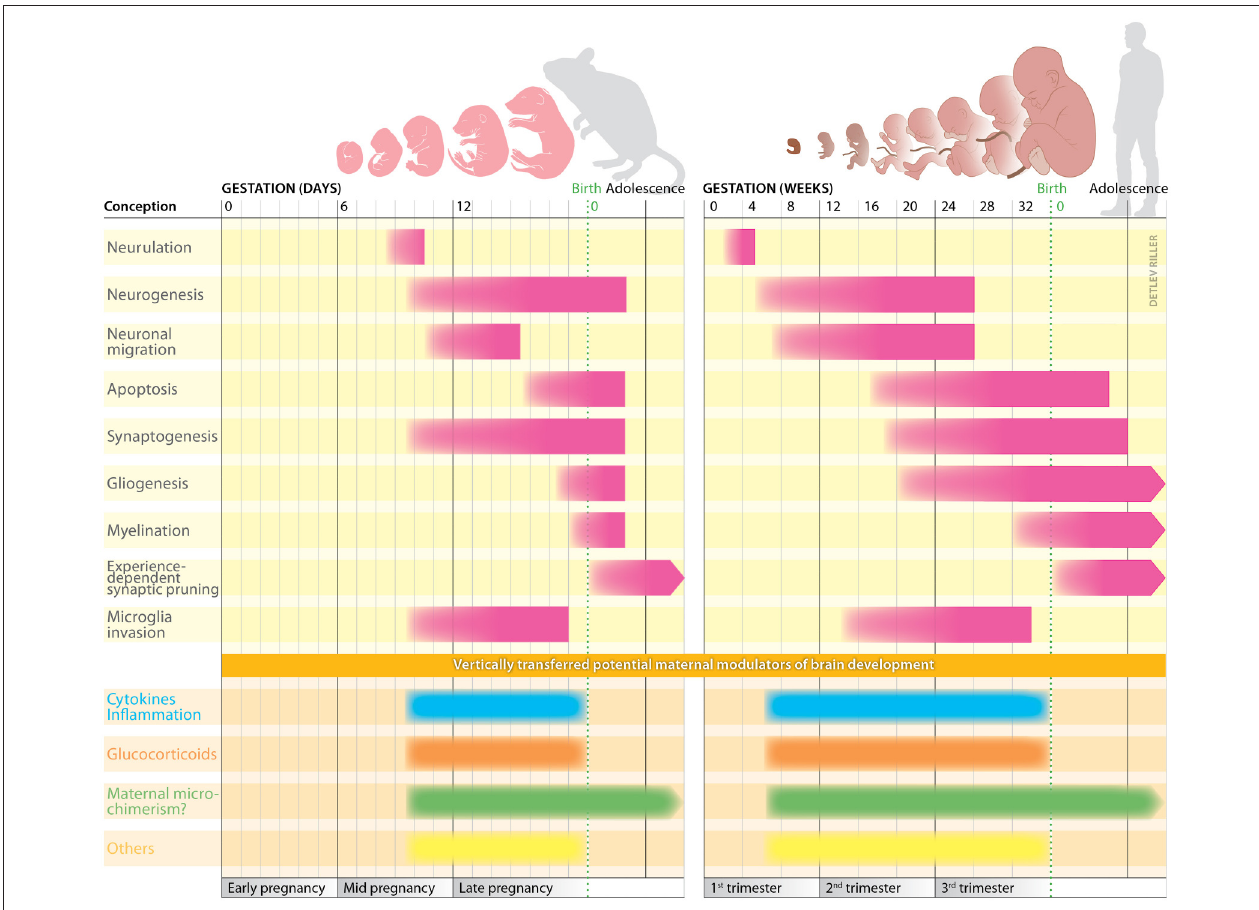
FIGURE 1 | Milestones of brain development in mice and humans. In both species, brain development commences with neurulation, a process creating the neural tube. This provides the prerequisite for the subsequent production of neuron from neural stem cells, a process defined as neurogenesis. Early during human development, at gestation week 4, the anterior part of the neural tube begins to form into distinct regions. The forebrain, midbrain and hindbrain are defined as the anterior part; the spinal cord is located at the posterior part. Two weeks later, the neural tube can be clearly divided into the brain regions that are present at birth. Some of the previously produced neurons now start to migrate to distinct brain regions, a process that continues until approx. week 26. Earlier by week 11, the cerebrum has developed—more rapidly than other structures—and largely covers the entire brain, except cerebellum and medulla oblongata. Due to its progressive development within the cranium, the cerebrum is forced to convolve itself resulting in gyri and sulci ( 51). During the second trimester of pregnancy, several processes start to define brain connectivity. These include synaptogenesis, gliogenesis, and apoptosis. Simultaneously, microglial cells invasion begins. By mid-third trimester, the fine-tuning of neuronal connectivity starts with proliferation of myelin sheaths throughout the neurons of the central nervous system (52). Shortly after birth, the previously established neuronal connections are reduced based on neuronal activity, meaning a reduction of neuronal connections to the ones often used. Since murine gestation is much shorter compared to human pregnancy, some developmental steps continue to proceed after birth. In mice, neural development begins during mid-pregnancy, followed by neurulation and formation of the neural tube (53). Subsequently, production of neurons, their migration and the formation of synapses occur almost simultaneously. Also, yolk sac-derived microglial cells invade the fetus starting on day 9 of pregnancy (54). The developmental milestones underlying brain development in mice and humans are highly susceptible to challenges and can be modulated by maternal markers vertically transferred during pregnancy. Hereby, the time point and intensity of the challenges clearly determine the impact and damage they may